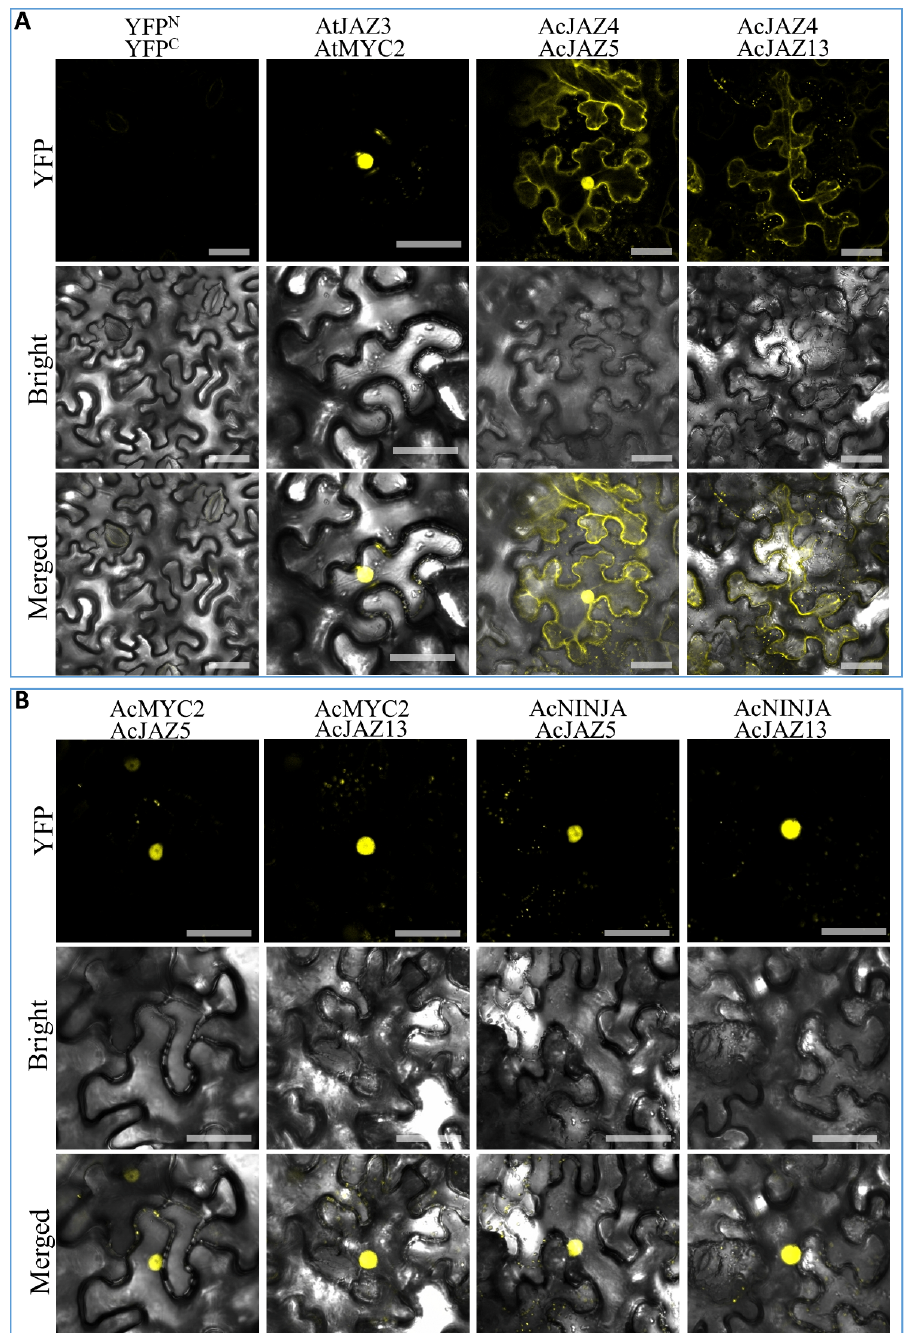
Figure 6. The protein–protein interactions among central regulators of the JA-signaling pathway in pineapple. The images were taken under detecting YFP fluorescence (on the top), bright field (in the middle), and combining fluorescence and bright field (merged images, on the bottom). ( A ) Negative control ( the empty vectors of YFP N and YFP C were transiently coexpressed in tobacco leaves), Positive control (construct pairs of YFP N -AtJAZ3 and YFP C -AtMYC2 were used as a positive control), and BiFC identification of the interactions of YFP N -AcJAZ4 with YFP C -AcJAZ5 and YFP C -AcJAZ13. ( B ) BiFC identification of the interactions of YFP N -AcMYC2 with YFP C -AcJAZ5 and YFP C -AcJAZ13, and YFP N -AcNINJA with YFP C -AcJAZ5 and YFP C -AcJAZ13. Scale bar = 50 μ m.